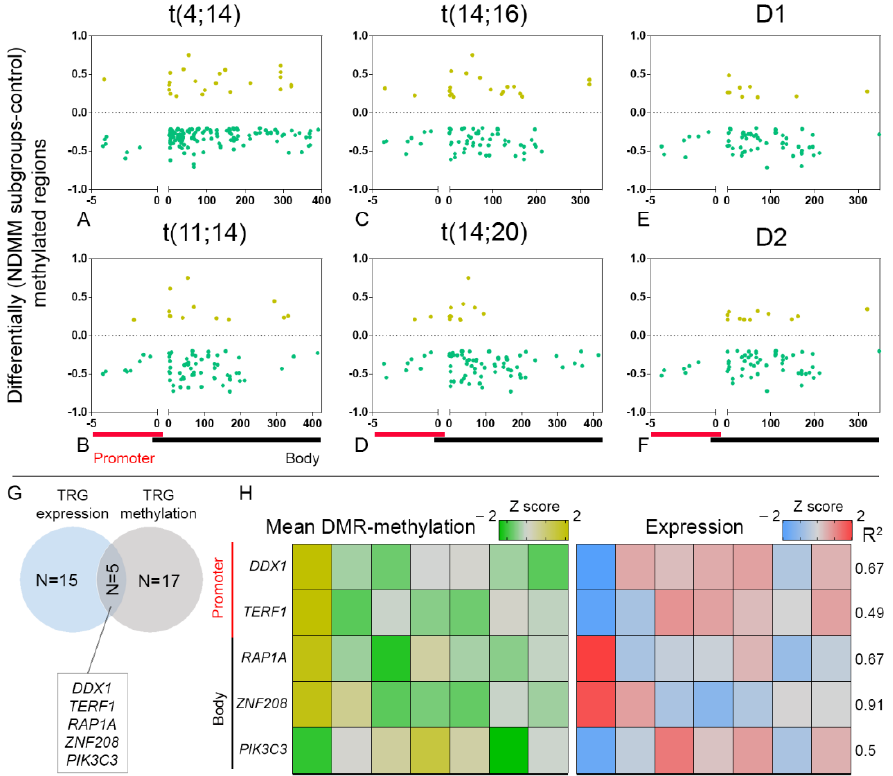
Figure 3. ( A – F ) Distribution of hypermethylated and hypomethylated DMRs across the promoters (−5 kb of TSS) and bodies (up to 3′ UTR) of TRGs among NDMM subgroups. ( G ) Out of 15 significantly (adj p < 0.05) differentially expressed and 17 differentially ( p < 0.05) methylated TRGs among NDMM subgroups, we observed 16% ( n = 5) of TRGs that were mutually inclusive to both the categories. ( H ) We observed strong correlation (R 2 ≥ 0.5) between MDM and expression in 5 TRGs, where an inverse methylation-expression at the promoter, or direct methylation-expression relationship at the body were considered. Abbreviations: DMR; differentially methylated regions; MDM, mean DMR-methylation; NDMM, newly diagnosed multiple myeloma; TRG, telomere-related gene; TSS, Transcription Start Site.